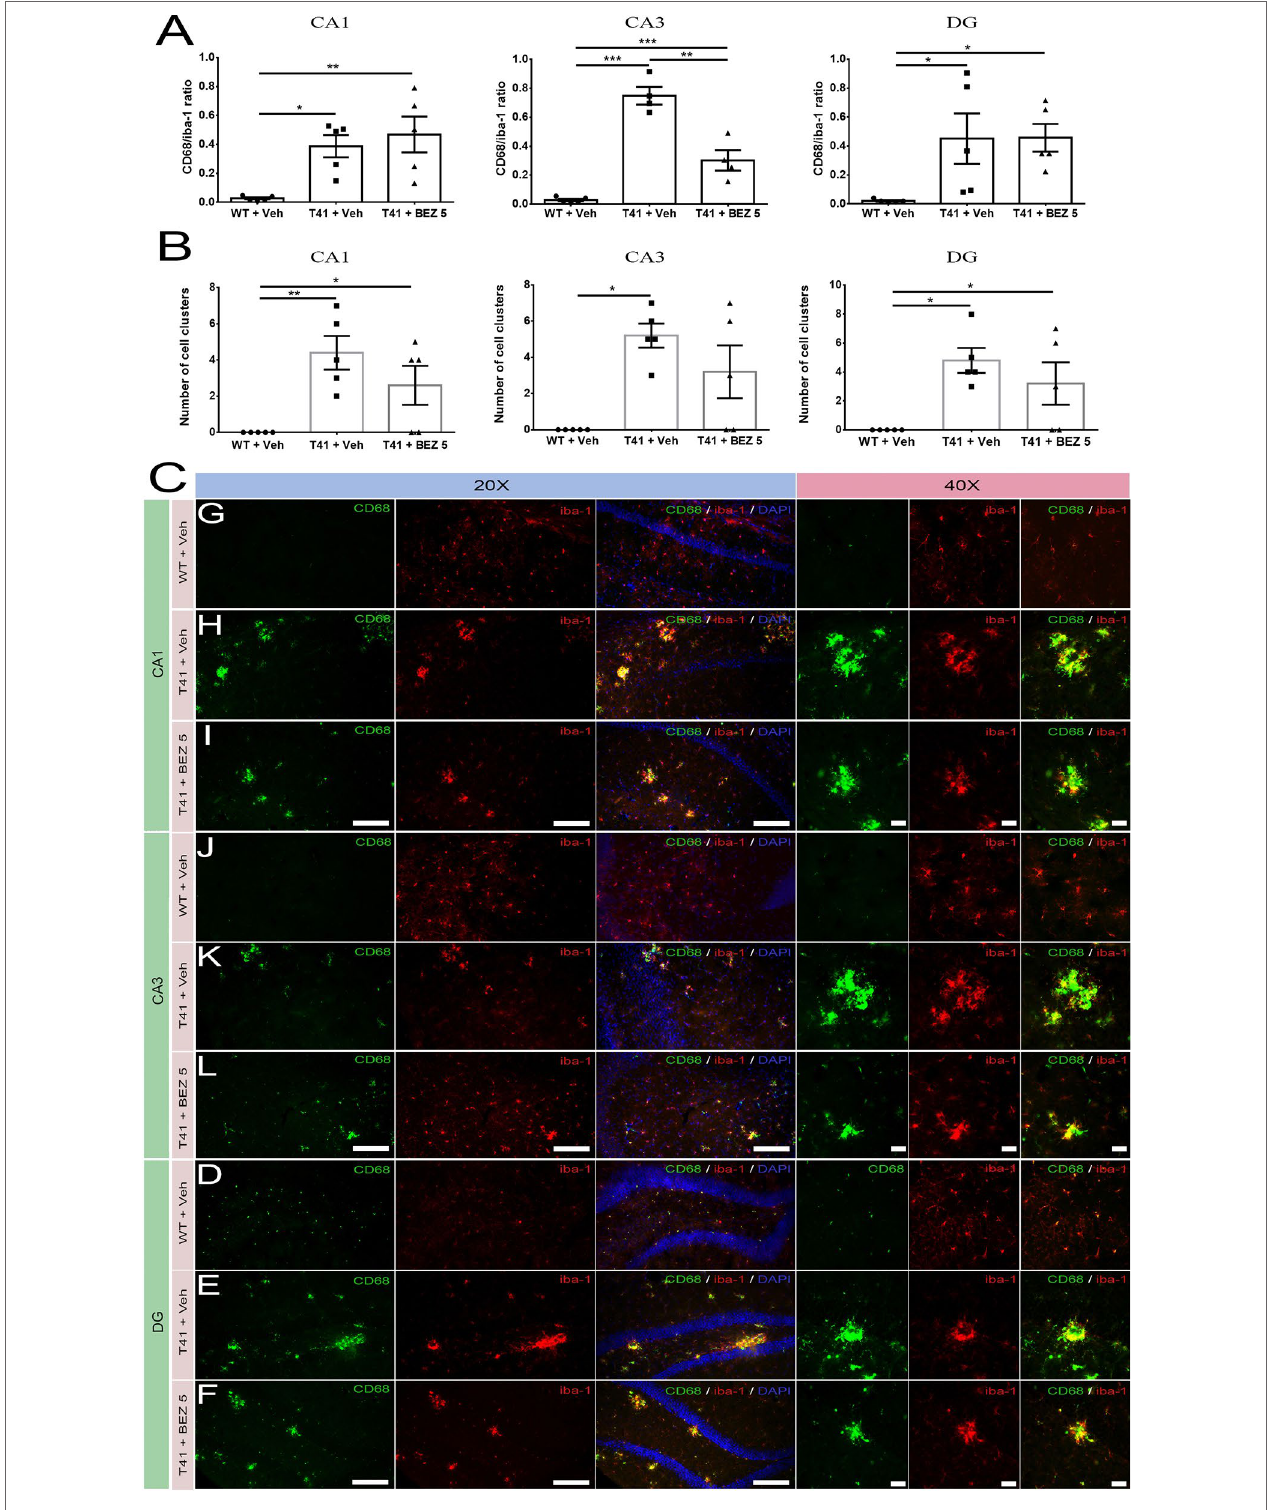
fIGURE 3 | Effects of BEZ treatment on CD68 and Iba-1 immunostaining ratio. Bar graphs represent the quantification of BEZ treatment effect on ratio between CD68 and Iba-1 immunostaining (A) or the number of Iba-1 + cell clusters (B) in CA1, CA3, and DG. Representative images are shown in 20× and 40× magnitude (C) . For CD68 and Iba-1 immunofluorescence, it was used WT + Vehicle (n = 5), T41 + vehicle (n = 5), and T41 + BEZ 5 (n = 5). *p < 0.05, **p < 0.01, and ***p < 0.001 (ANOVA followed by Newman-Keuls test). Scale bar for 20× objective = 125 µm. Scale bar for 40× objective = 10 µm.